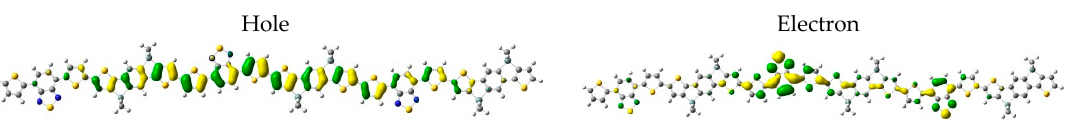
Figure 1. Charge density isosurface of the electron and hole natural transition orbitals of the lowest energy electronically excited state in the trimer of SiIDT-DTBT, depicting the charge density distribution upon excitation by light. Calculations were performed by TD-DFT B3LYP/6-31g* and are taken with permission from reference [13].